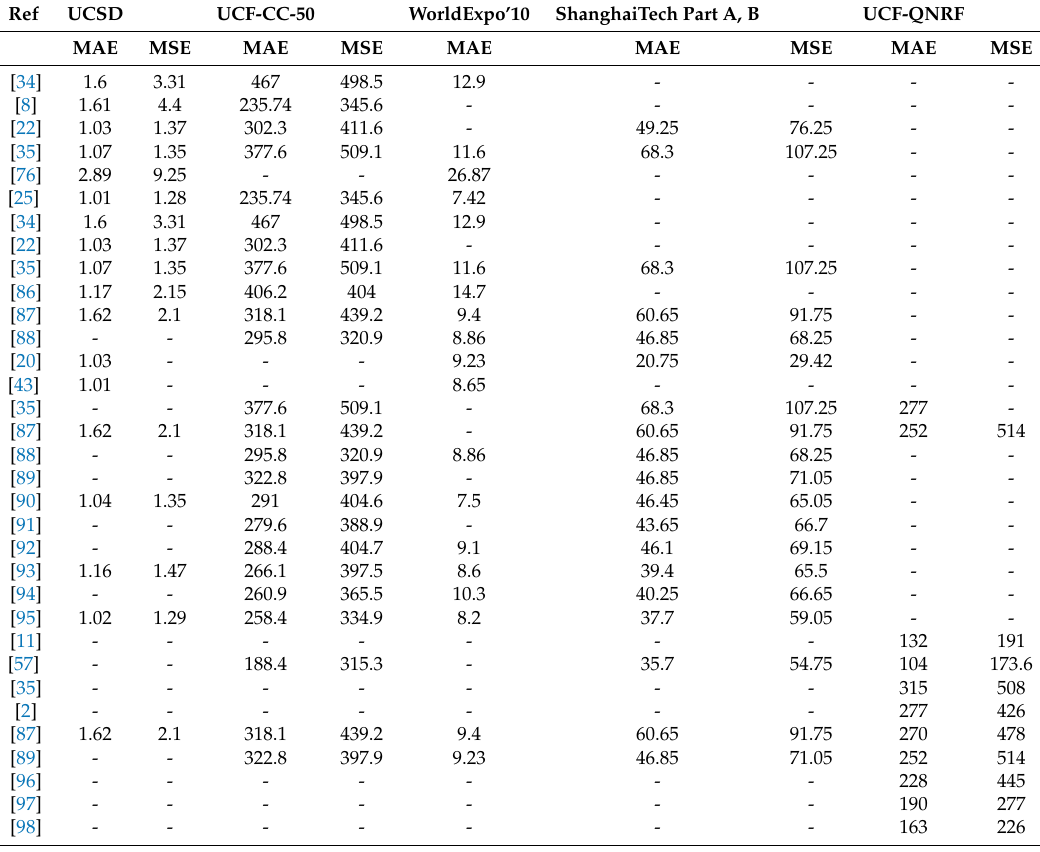
Table 4. Comparison of surveyed methods and test